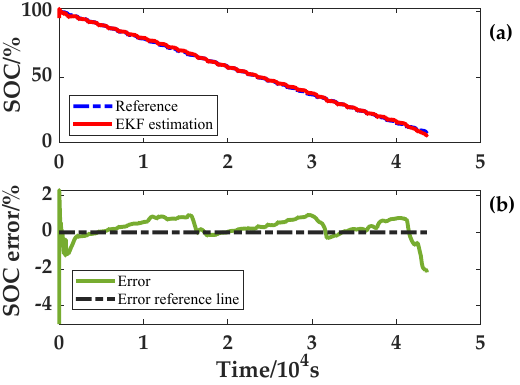
Figure 15. SOC estimation result and error of the temperature drop experiment. ( a ) SOC estimation result and ( b ) SOC estimation error.